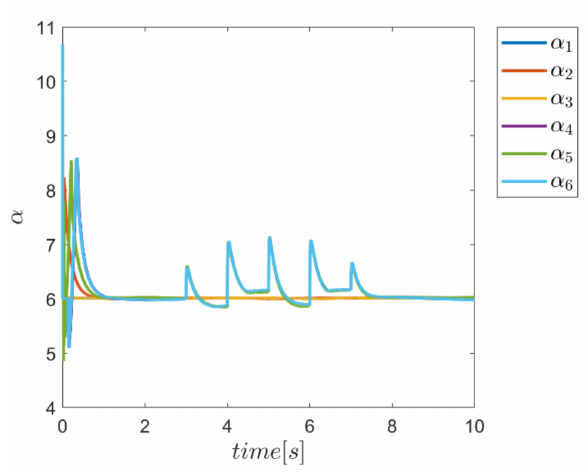
Figure 25. Adaptive variation of the coefficents of α for individual α fuzzy system.